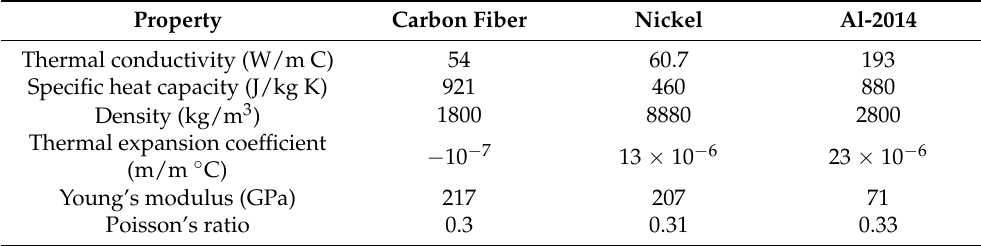
Table 1. Material parameters gleaned from [35] and used in ProCast’s CAFE simulation.